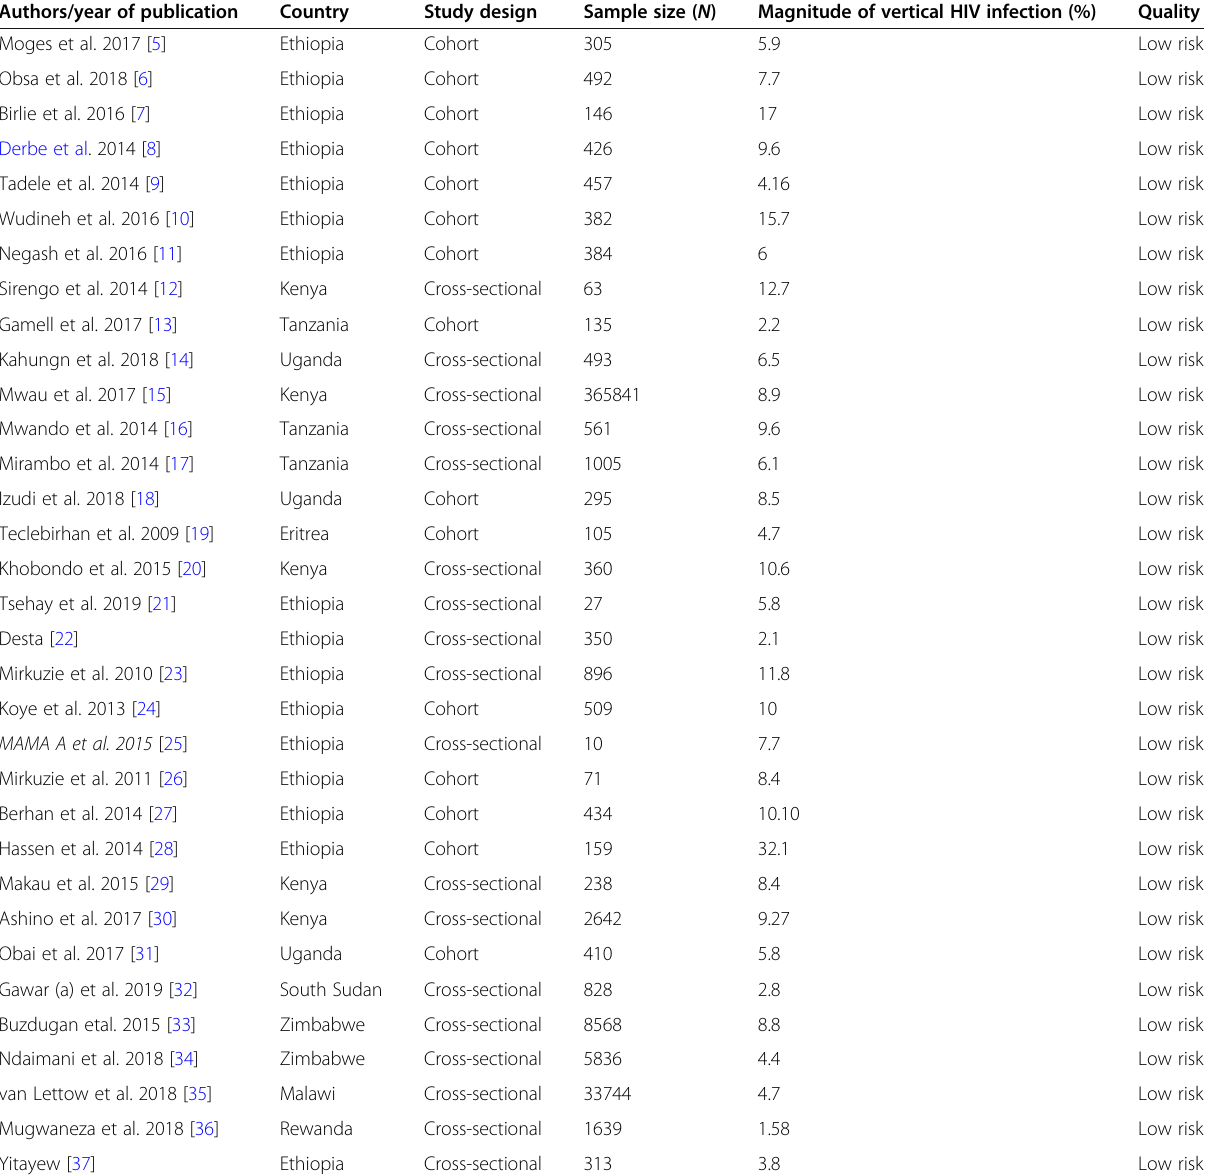
Table 1 Descriptive summary of 33 studies included in the meta-analysis of the prevalence of vertical HIV infection in East